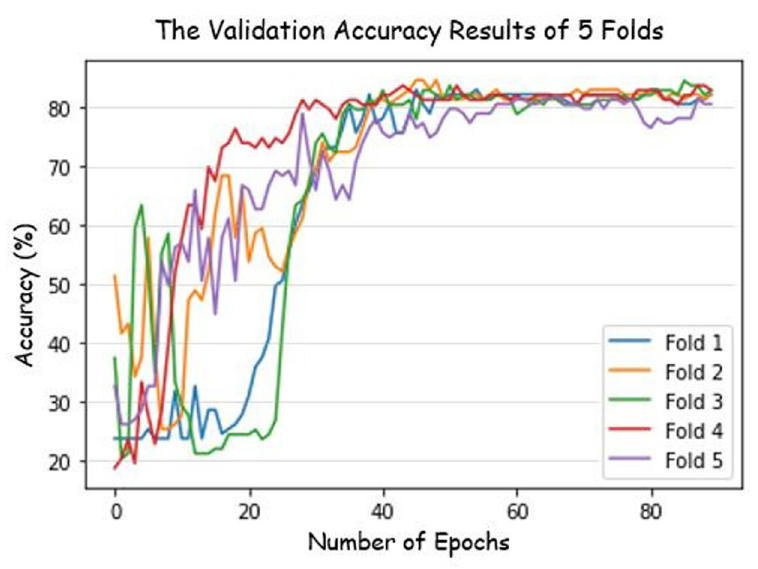
Fig 6. Validation accuracy of our custom CNN model with the directional filters over 5 folds. Five different folds were used for testing the model. The behaviors of the trainings are consistent with one another. The final accuracy is above